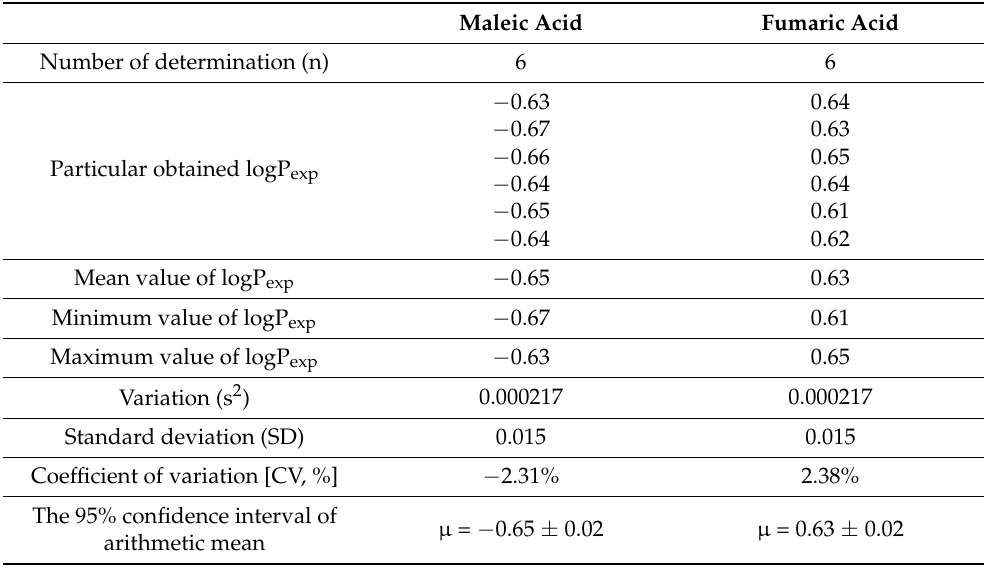
Table 3. Statistical analysis of the obtained experimental partition coefficient (logP exp ) of maleic acid and fumaric acid determined in the n -octanol–water system. Maleic Acid Fumaric